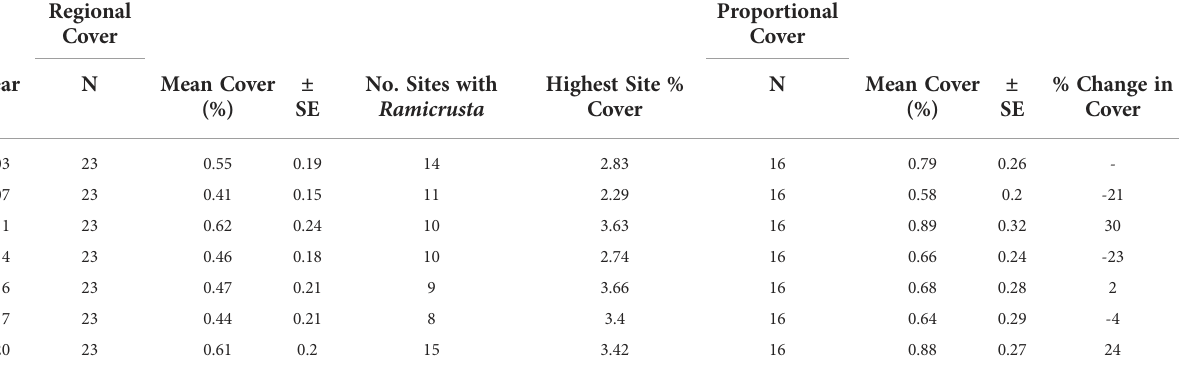
TABLE 2 Summary of Ramicrusta cover at the DAR-WHAP sites assessed in this study. Regional